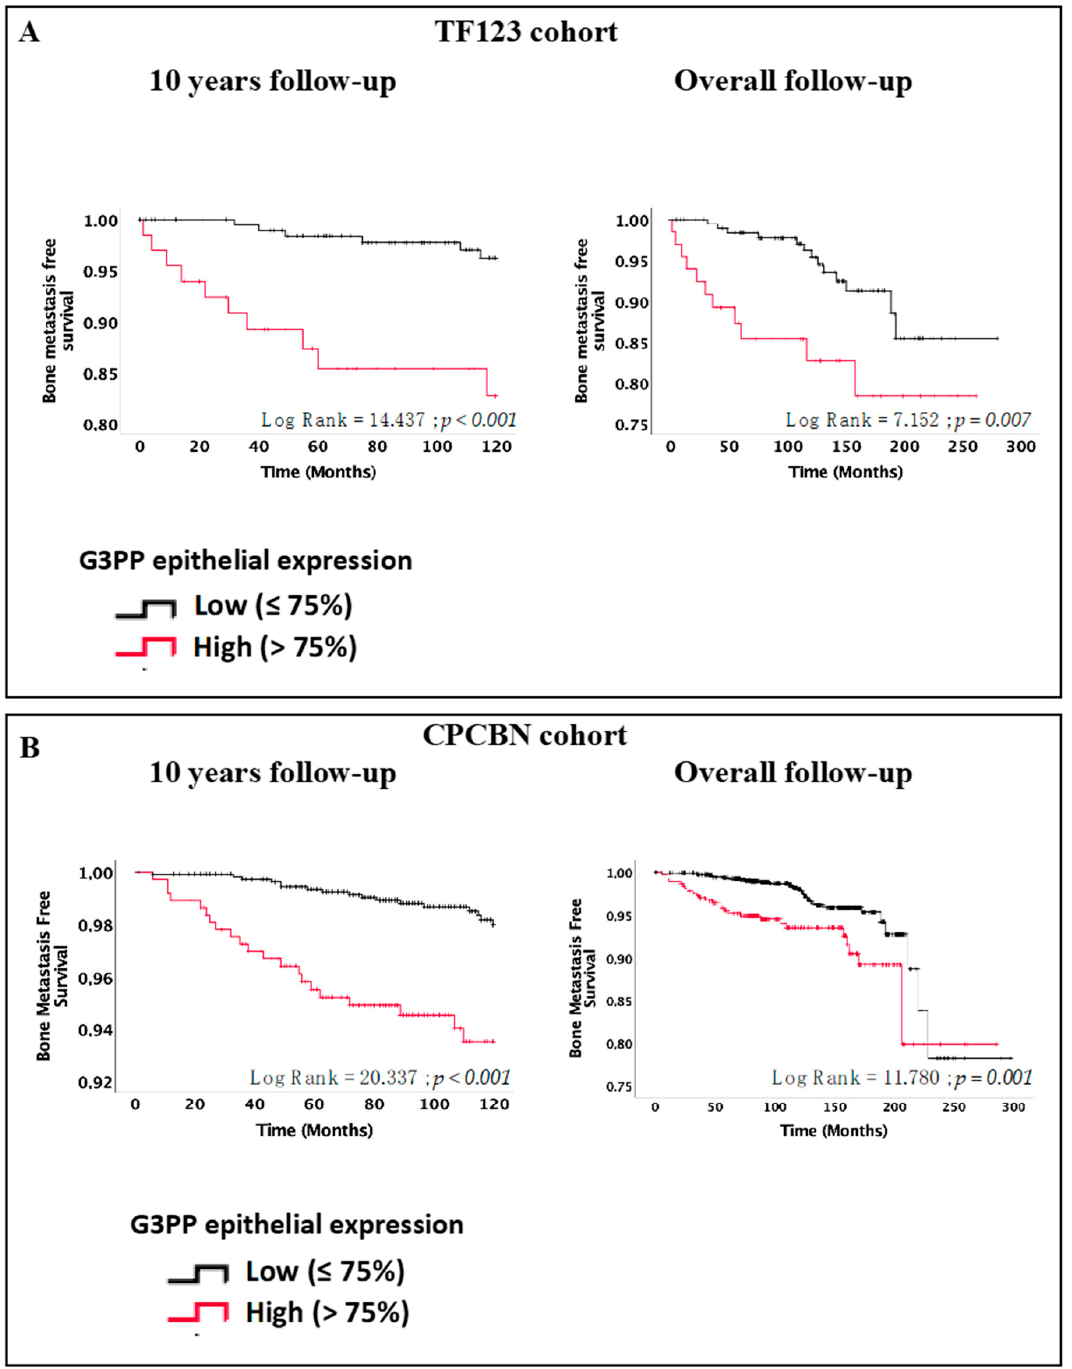
Figure 3. High expression of G3PP is associated with increased risk of bone metastases after 10 years and overall follow-up. Kaplan–Meier bone metastasis-free survival curves after 10 years and overall follow-up for the TF123 (A) and CPCBN (B) cohort TMAs.